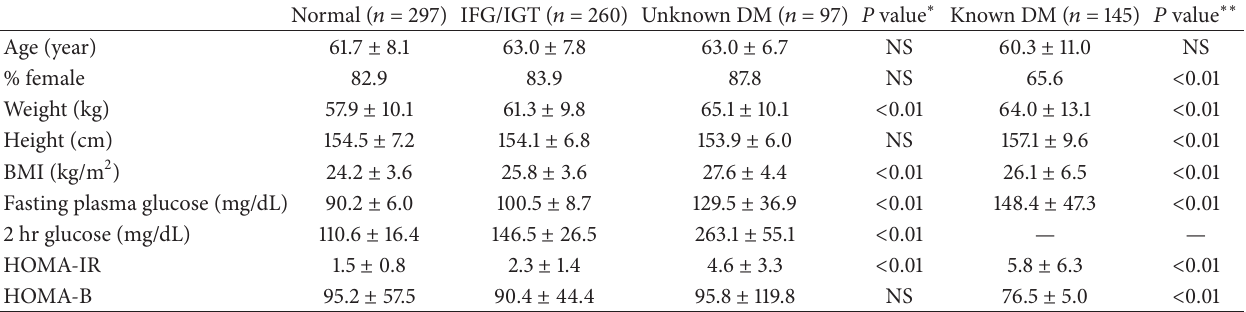
Table 1: Clinical characteristics of the study